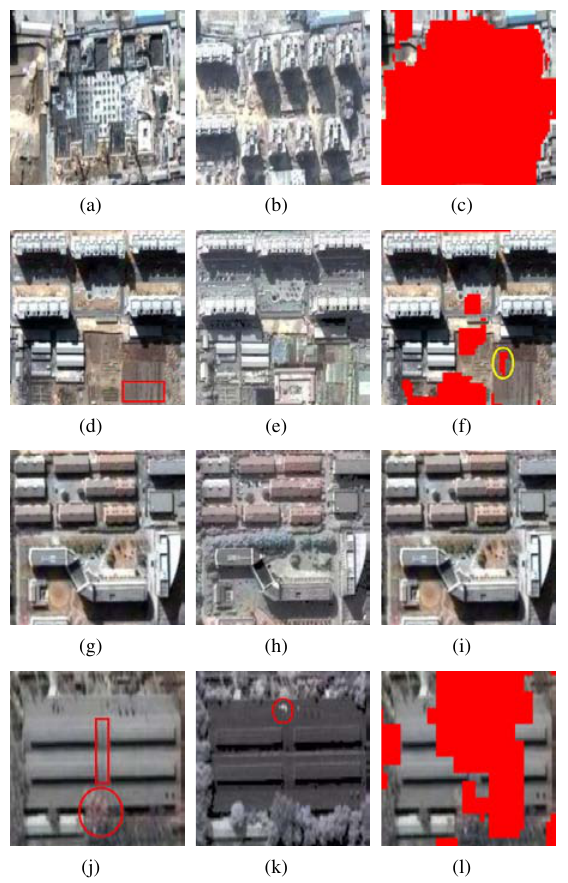
Figure 7: Four cases used for performance analysis. Case 1(the first row):complex changes are detected correctly. Case 2(the sec- ond row): changed regions are detected in part. Case 3(the third row): unchanged regions are detected correctly. Case 4(the fourth row): false alarms.